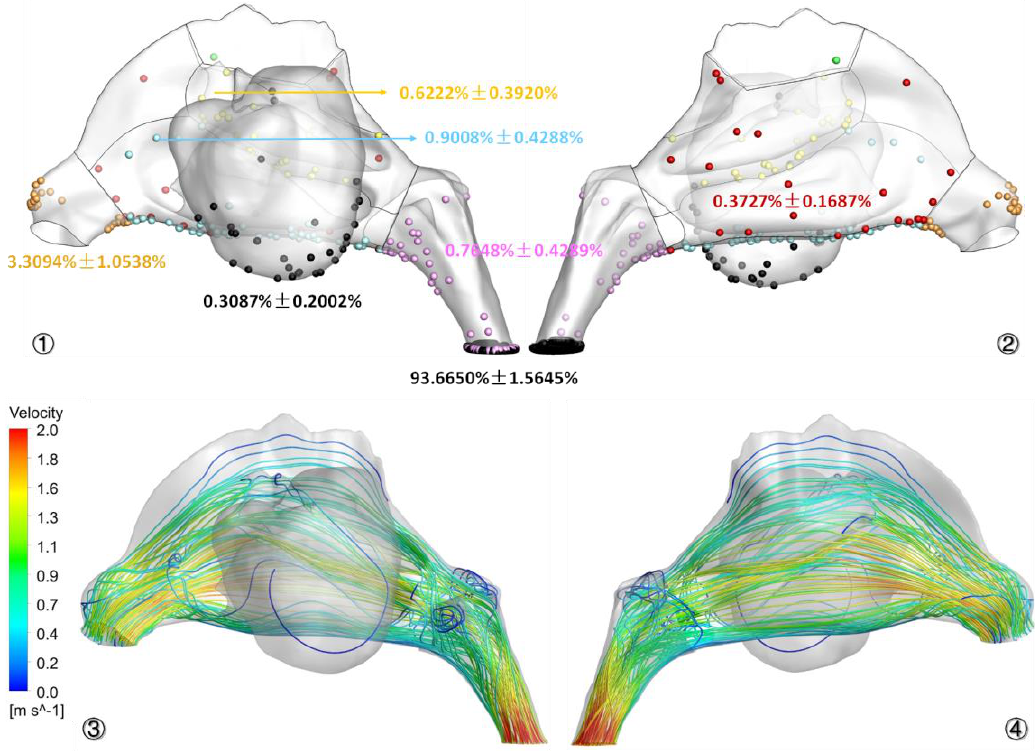
Figure 4. Under a 15 L/min inspiratory condition in the standing position, ① and ② show the deposition diagram and deposition rate of A. niger spores on the nasal cavity surface ( ① left view, ② right view); ③ and ④ show the particle trajectories of A. niger spores moving with airflow ( ③ left view, ④ right view) (orange: nasal vestibular; red: nasal septum; black: maxillary sinus; pink: nasopharynx; green: olfactory area; yellow: middle turbinate area; blue: inferior turbinate area).